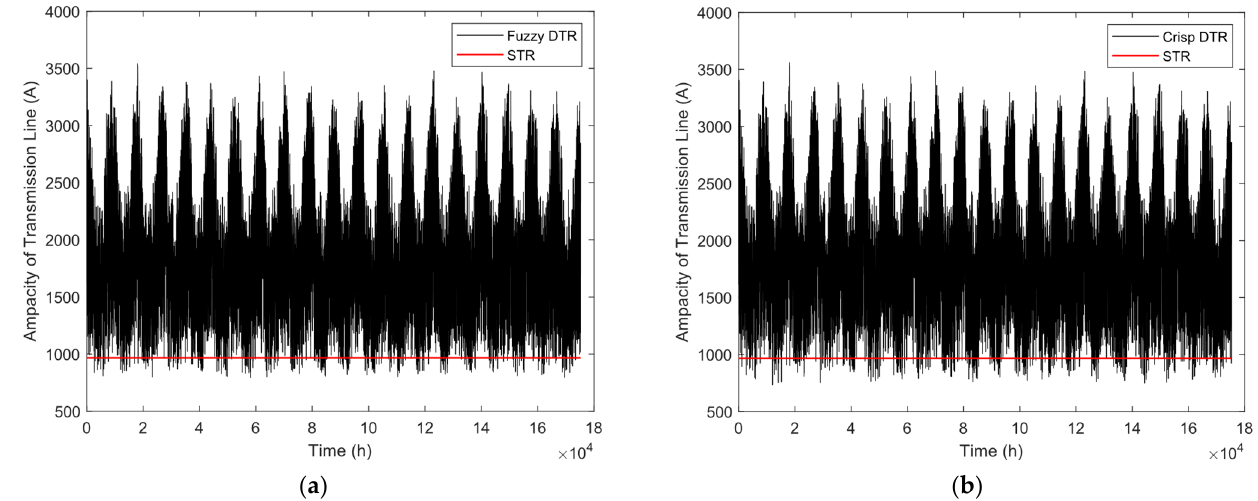
Figure 8. ( a ) Fuzzy current carrying values based on twenty years of meteorological data; ( b ) crisp current carrying values based on twenty years of meteorological data.